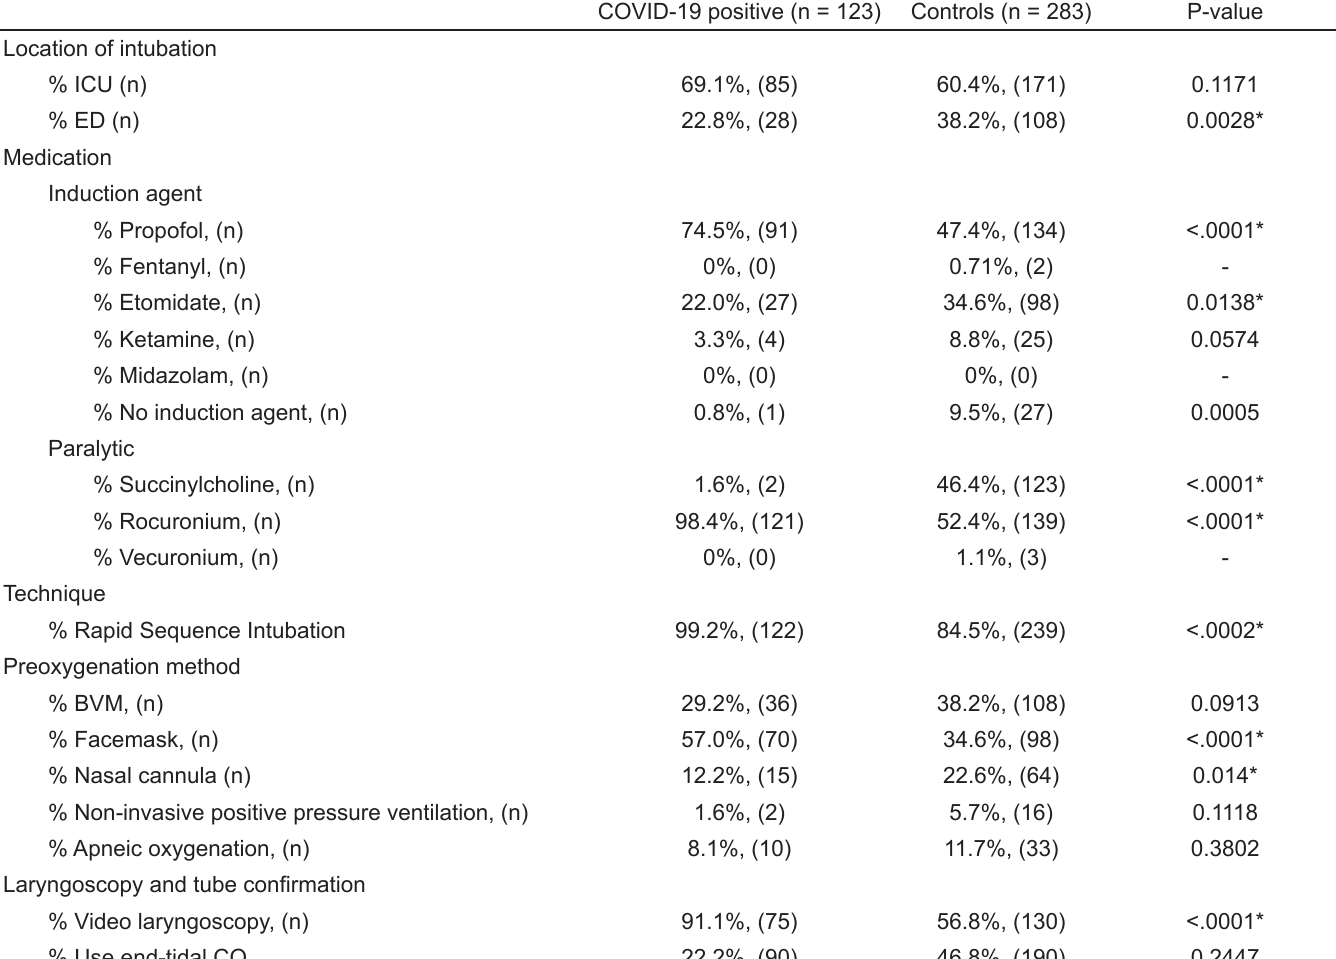
Table 3. Location, selection of pharmacologic agents intubation technique associated with COVID-19 compared with controls. An asterisk indicates where α <